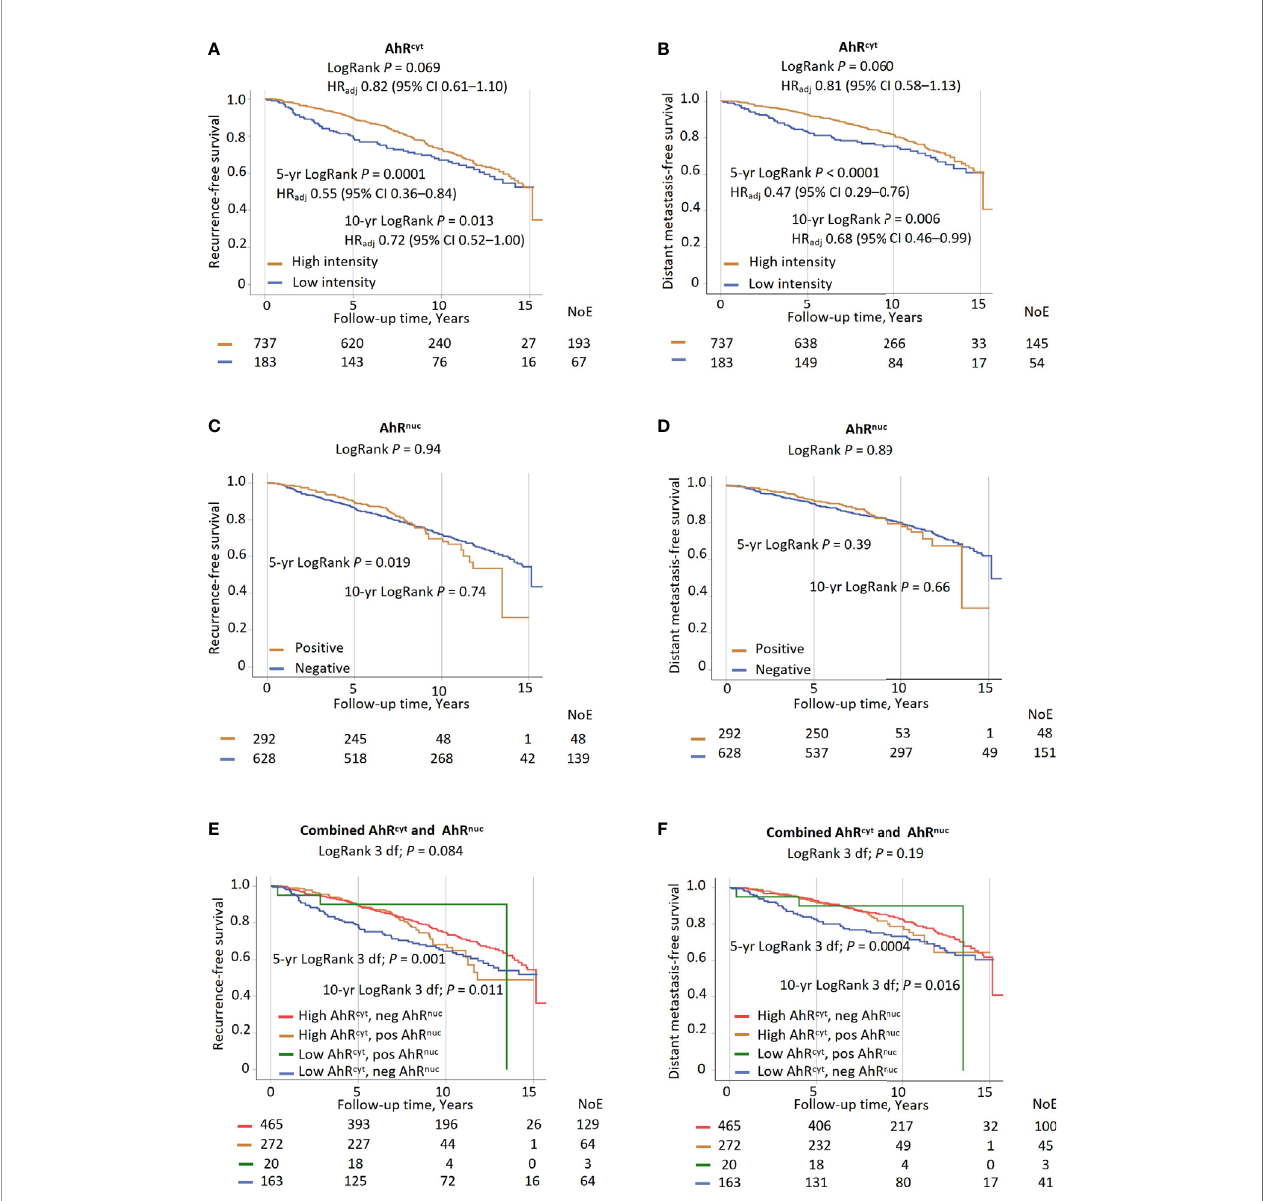
FIGURE 2 | High AhR cyt levels comparedto low AhR cyt in relation to 5-year, 10-year,and the entire follow-up: (A) recurrence-free survivaland (B) distant metastasis-free survival. Positive AhR nuc levels compared to negative AhR nuc statusin relation to 5-year, 10-year,and the entire follow-up (C) recurrence-free survivaland (D) distant metastasis-free survival. Associations(3 d.f.) between fourgroups of AhR cyt levelsand AhR nuc status (highAhR cyt and positive AhR nuc ; high AhR cyt andnegative AhR nuc ; low AhR cyt and positive AhR nuc ; low AhR cyt and negative AhR nuc ) and 5-year,10-year andthe entire follow-up (E) recurrence-free survivaland (F) distant metastasis-free